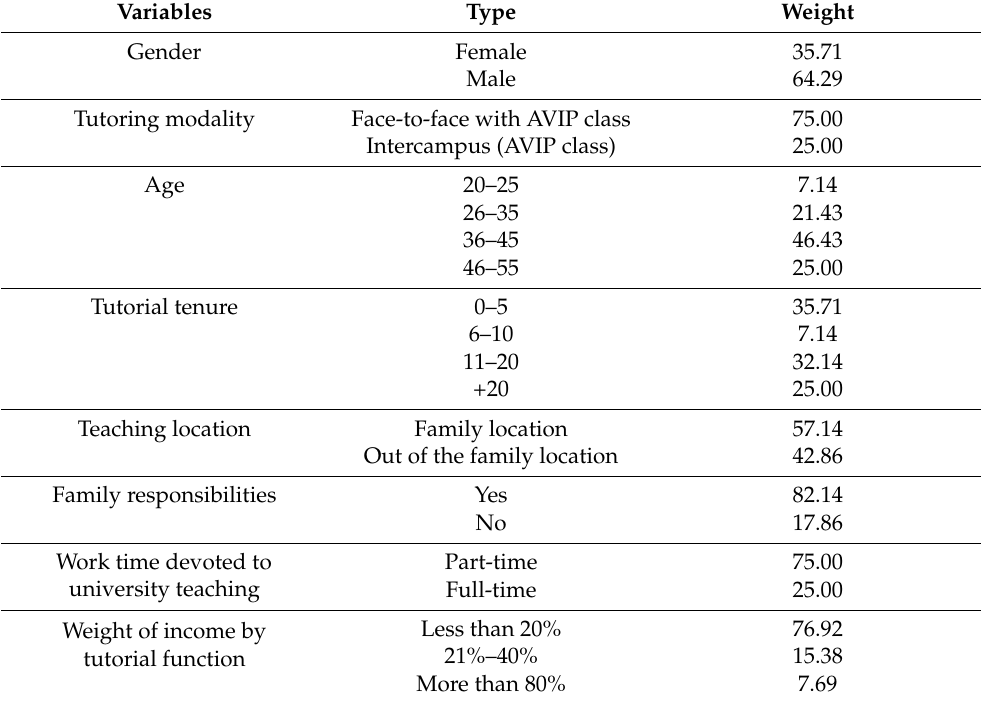
Table 1. Sample descriptive